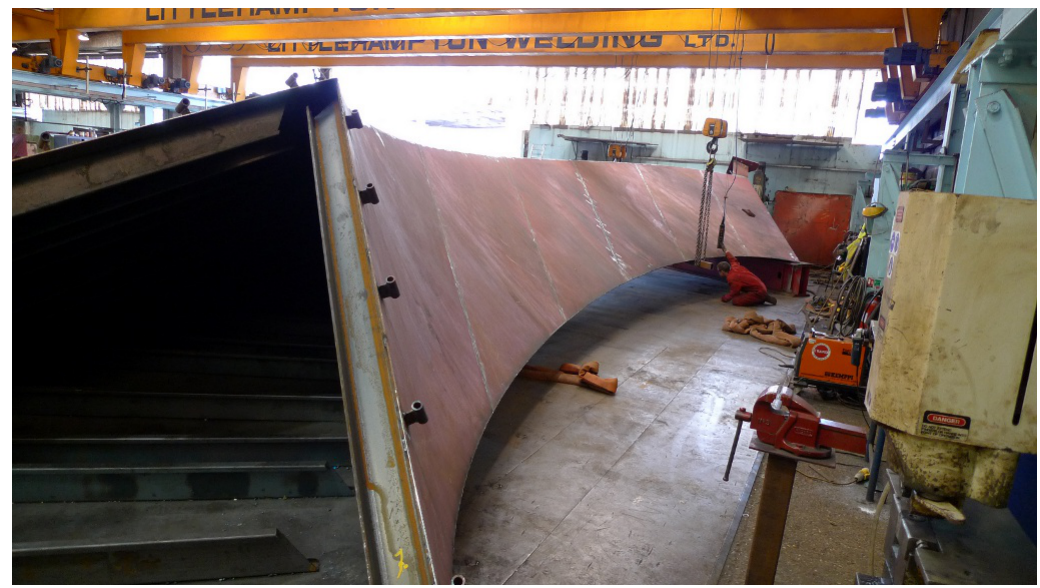
Figure 27. Assembly of one segment. This is 18 m long and the full sculpture consists of eleven different